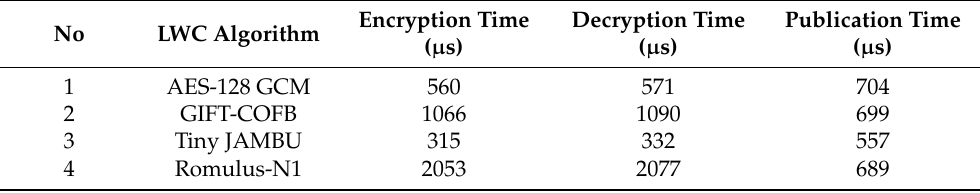
Table 4. Lightweight Cryptographic Encryption and Decryption Performance on NodeMCU with 15 Characters Messages used Anonymous Account.